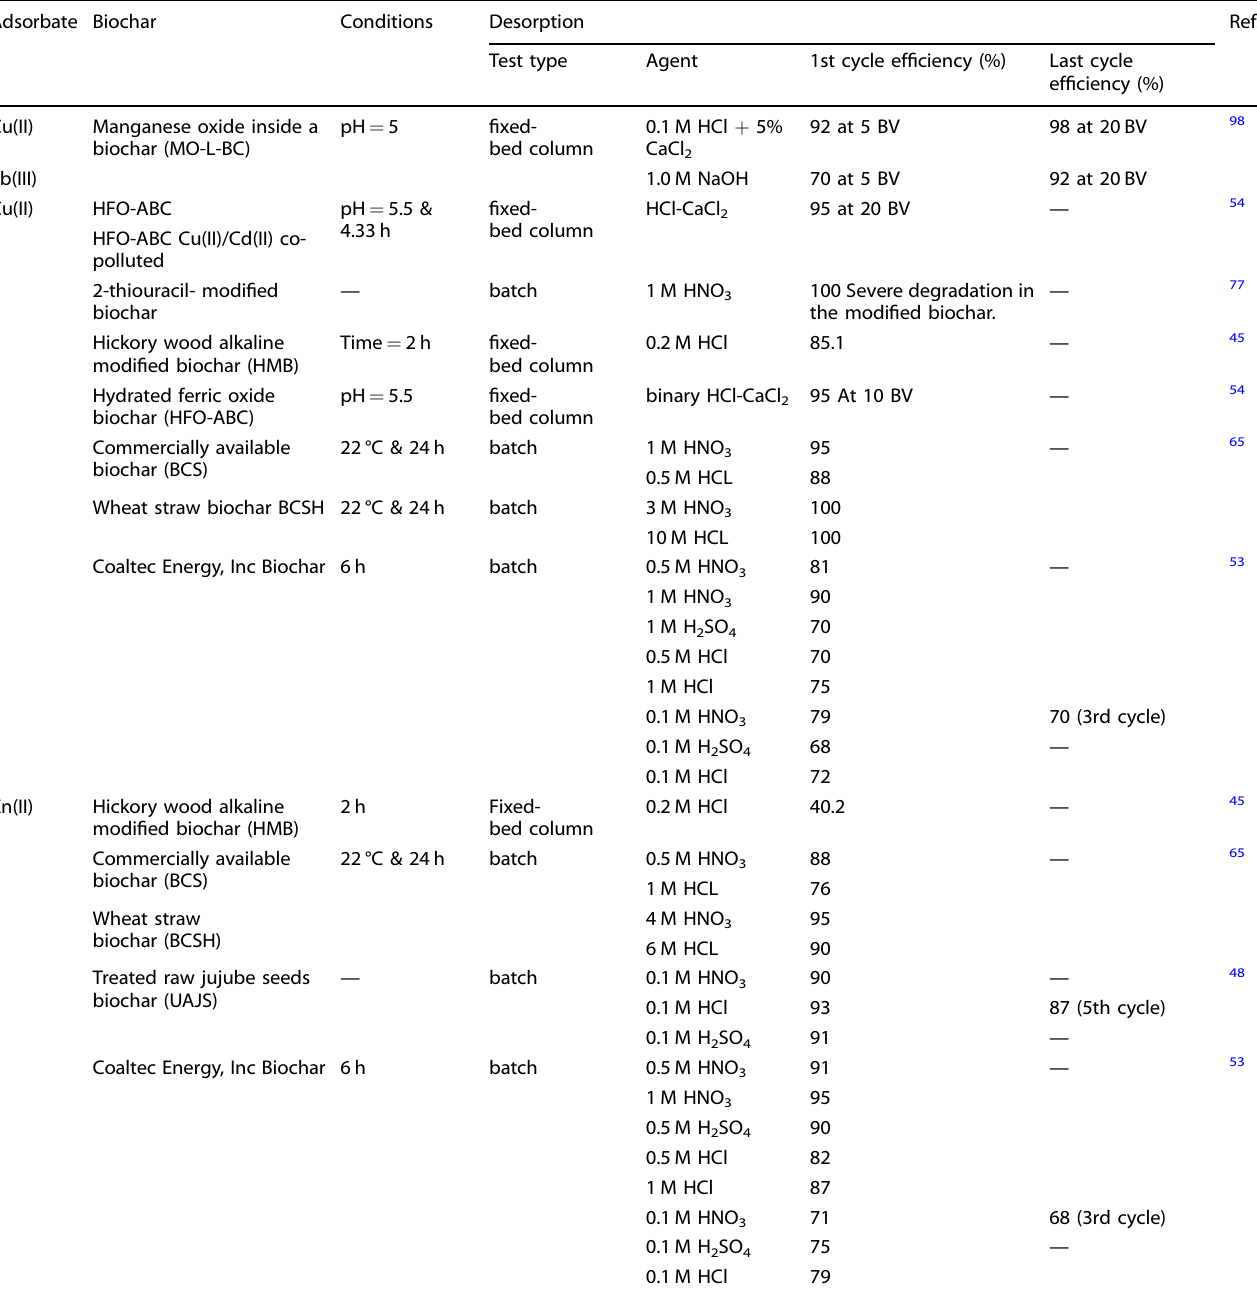
Table 6. Chemical desorption ef fi ciencies of biochar after adsorbing Cu(II) and Zn(II) from wastewater. Adsorbate